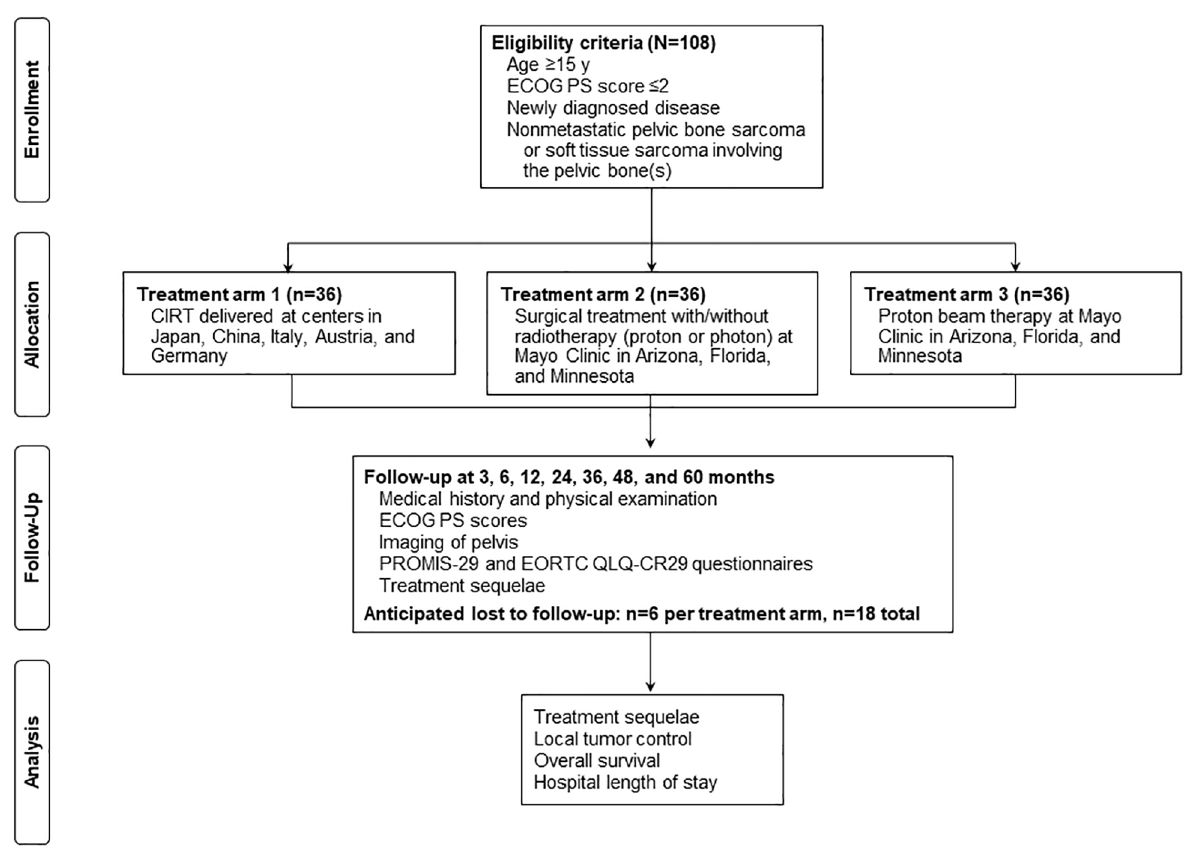
Figure 1. Treatment arms. CIRT indicates carbon ion radiotherapy; ECOG PS, Eastern Cooperative Oncology Group Performance Status; EORTC, European Organisation for Research and Treatment of Cancer; PROMIS-29, Patient-Reported Outcomes Measurement Information System-29; QLQ-CR29, colorectal cancer–specific quality of